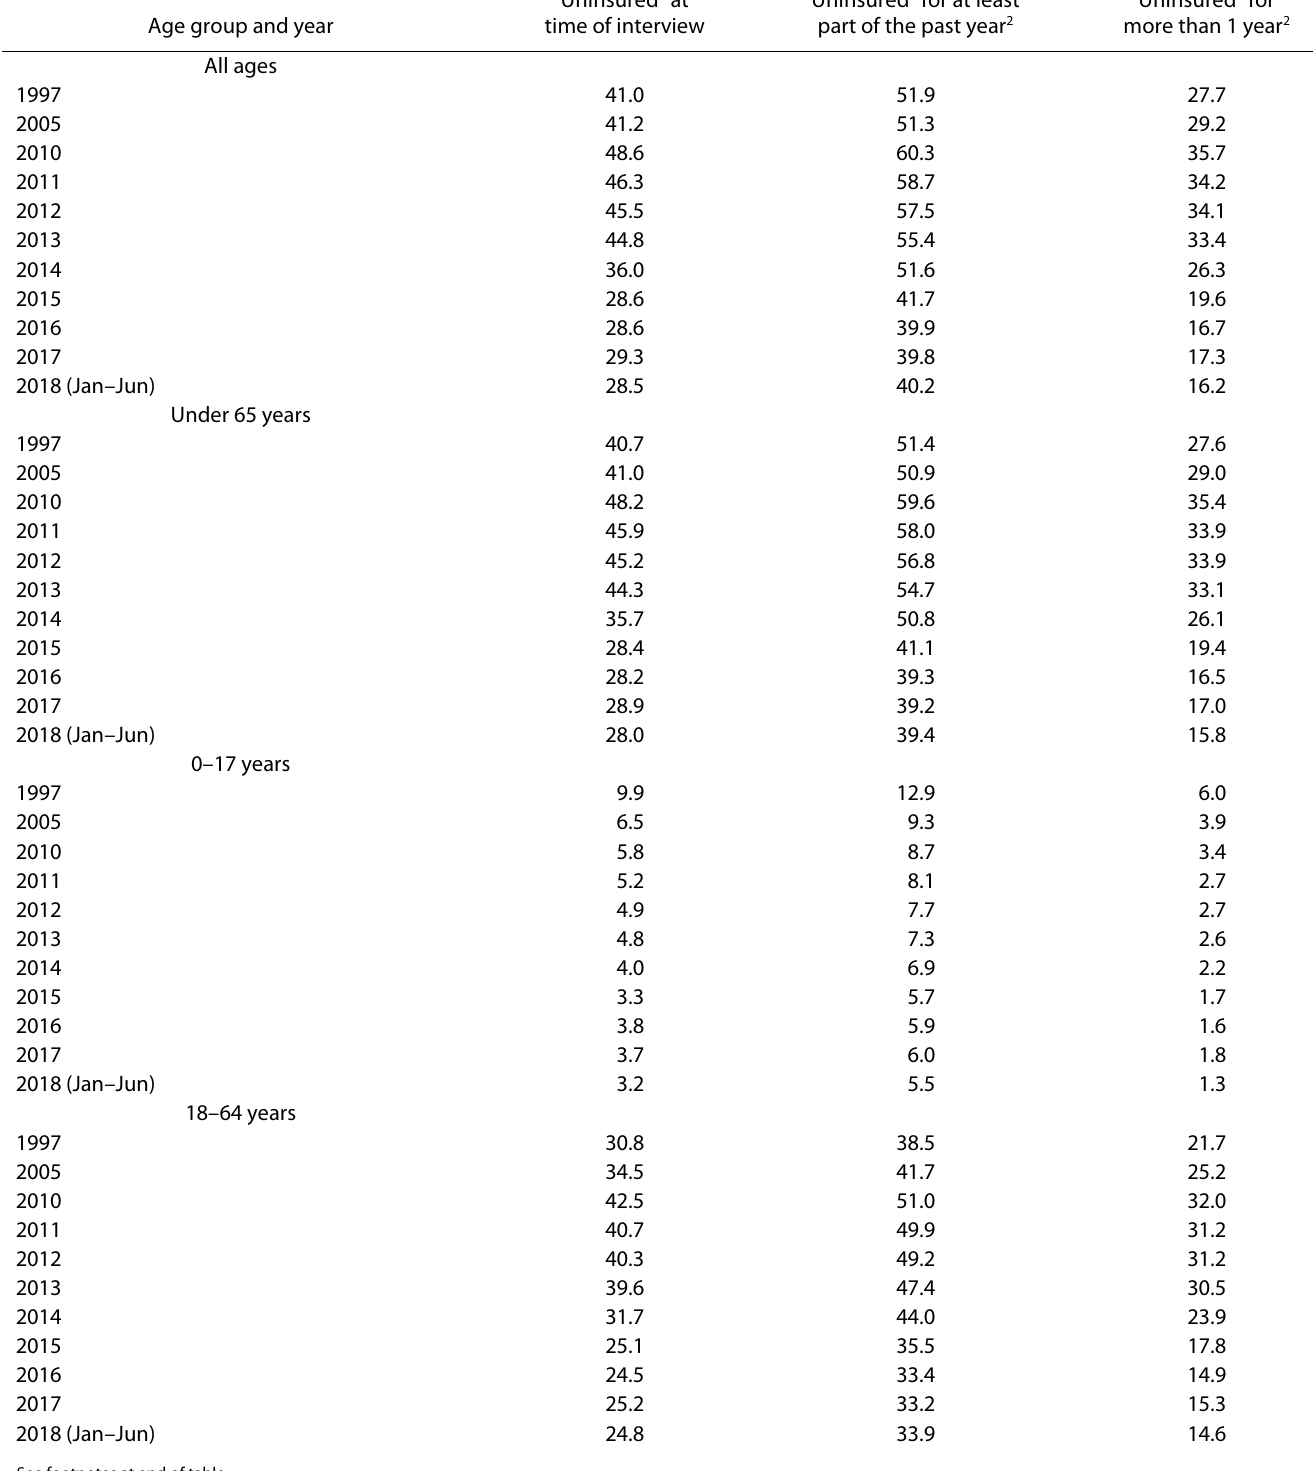
Table II. Numbers (in millions) of persons who lacked health insurance coverage at the time of interview, for at least part of the past year, and for more than 1 year, by age group and selected years: United States, 1997–June